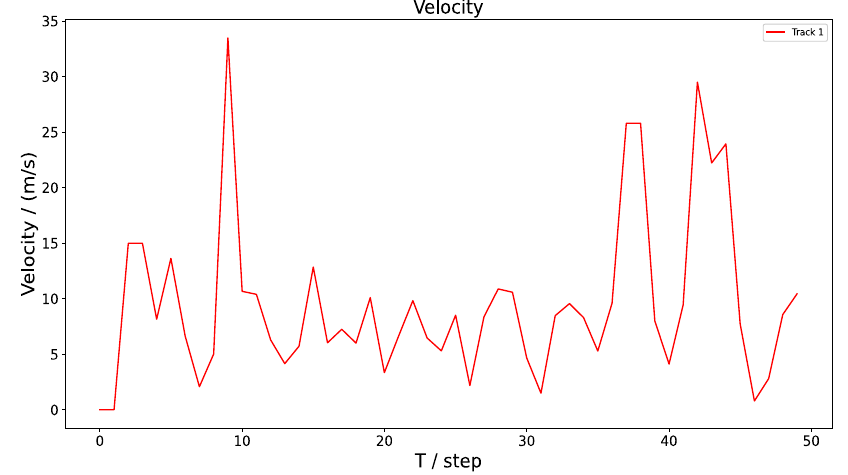
Figure 17. Single-target velocity estimation (CMKF-REMTT).